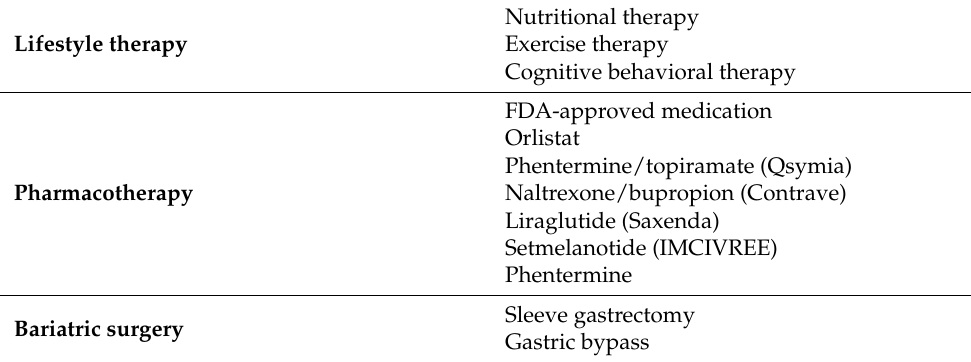
Table 1. Treatment options of